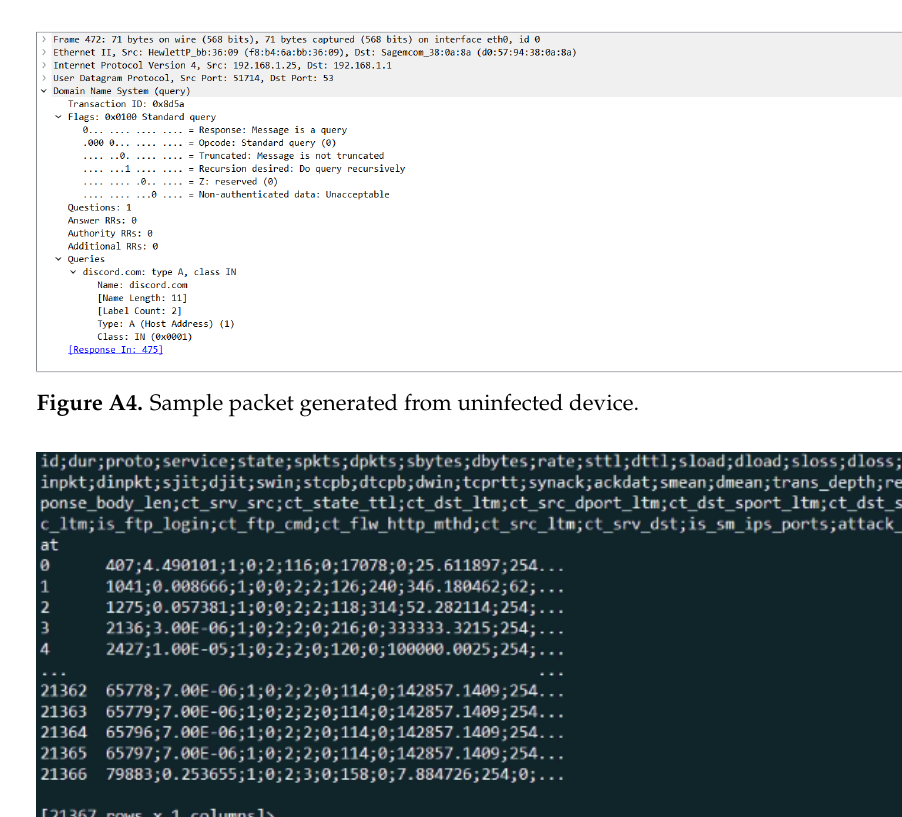
Figure A3. Sample packet generated from Iodine tunneling tool.